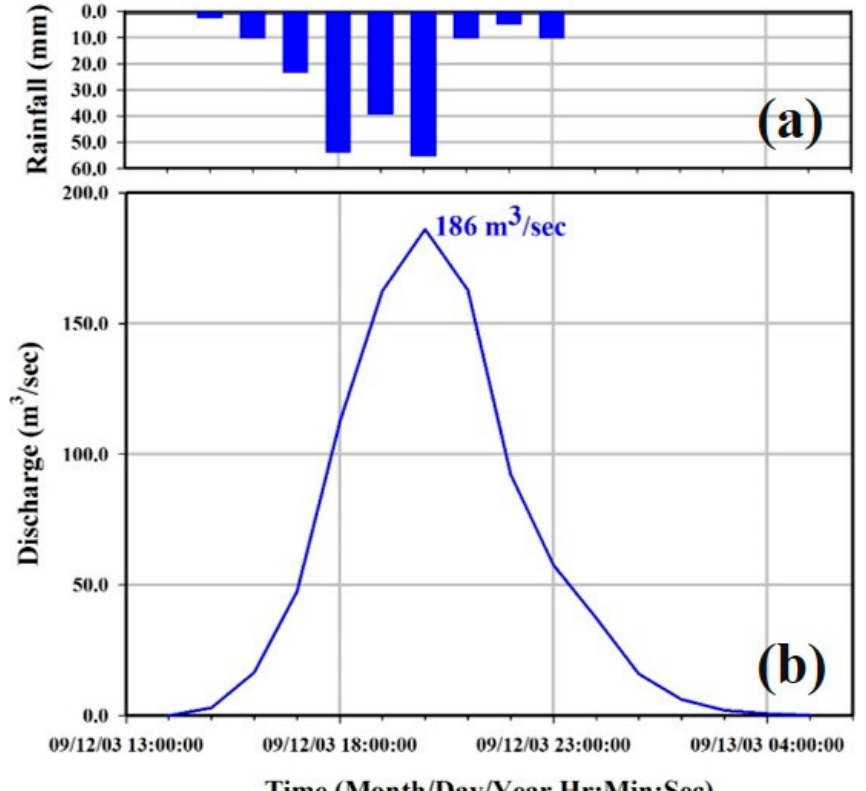
Figure 4. Temporal distributions of the rainfall ( a ) and flood inflow ( b ).